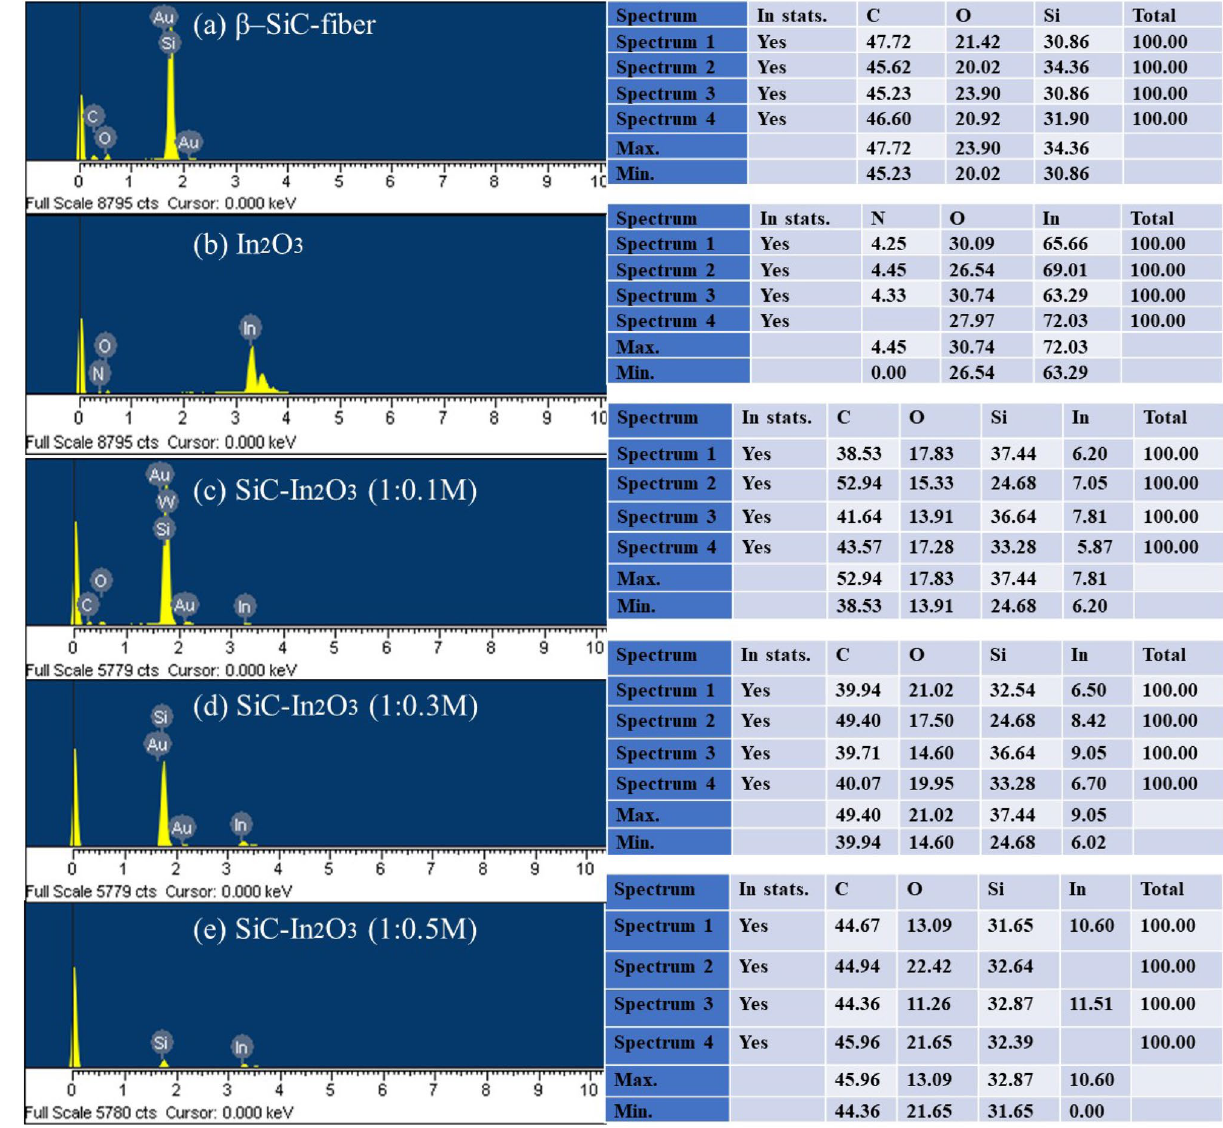
Figure 2. EDX analysis of the In 2 O 3 , β-SiC fiber and SiC-In 2 O 3